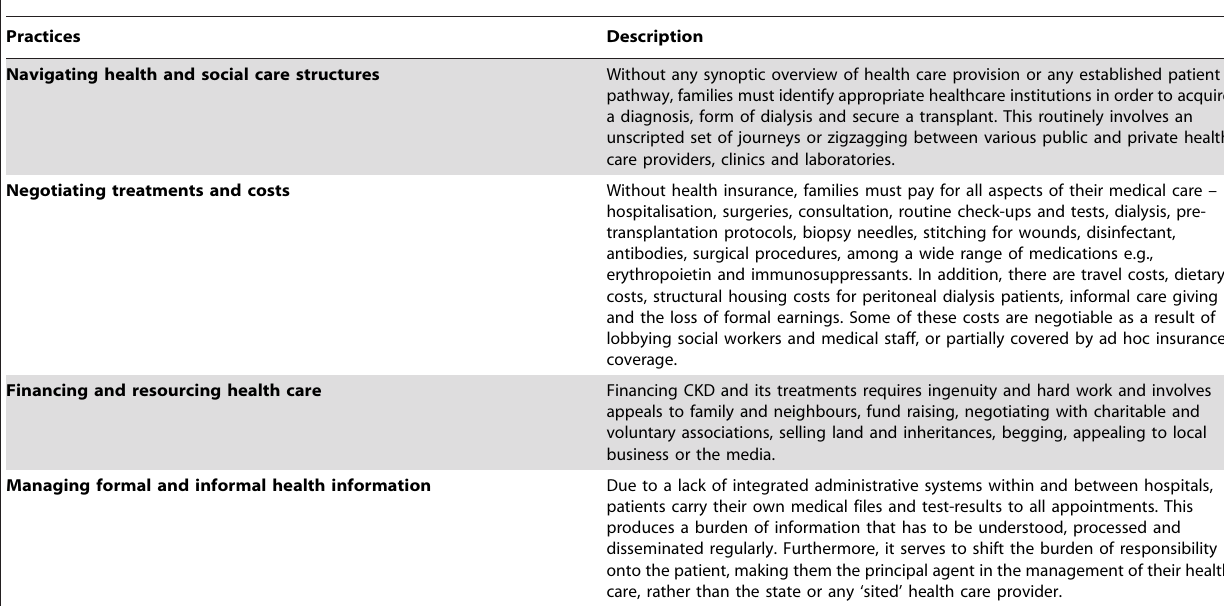
Table 5. The Practical Work done by Mexican CKD Patients and their